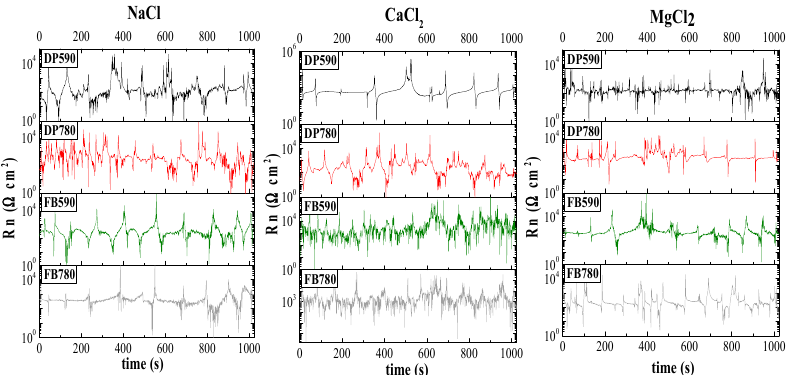
Figure 6. Instantaneous measured R n for different steels in NaCl, CaCl 2 and MgCl 2 solutions. This type of transients are related to the susceptibility and corrosion type according to L.I., skewness and kurtosis statistical measurements [43].